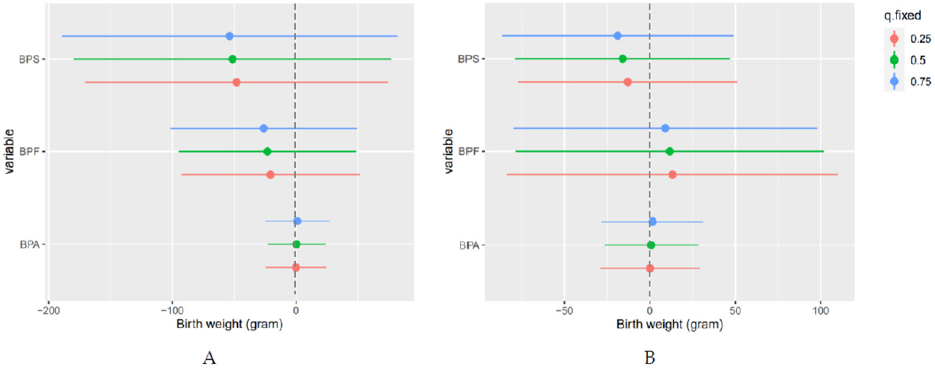
Figure 2. Change in average birth weight (estimates and 95% credible intervals, gray dashed line at the null) ( A ) for increase in each bisphenol from its 10th to 50th and ( B ) for increase in each bisphenol from its 50th 90th when the other bisphenols were set at their median values. Models were adjusted for maternal age, education, family income, smoking status, drinking status, body mass index, exercise, parity, infant sex, and gestational weeks (only in the case of birth weight). To examine potential pairwise interactions among the bisphenols, particularly due to the nonlinearity for BPF and BPS, we estimated the predicted change in birth weight and gestational age, considering the other bisphenol patterns at 25th, 50th, or 75th percen- tiles. Figure S3 shows possible interactions between BPF and BPS, where the negative slope of lower BPF levels with birth weight is slightly steeper at higher BPS levels than at lower BPS levels and the negative slope of BPS with birth weight is slightly steeper at higher BPF levels than at lower BPF levels. The interactions of bisphenols with gestational weeks were not noticeable in this study population. Finally, we also examined the overall effect of bisphenol mixtures on birth outcomes. Figure 3 shows the estimated change in the average birth weight and gestational age when all the bisphenols were at a certain percentile (from the 10th to 85th percentile) compared with when they were at their median values (50th percentile). For example, bisphenols set at their 80th percentile were associated with a 20.1-g (SD: 37.1) decrease compared with when all the bisphenols were set at their 50th percentiles. Increasing levels of the bi- sphenol mixture were associated with a decrease in birth weight. However, we found no changes in gestational age.